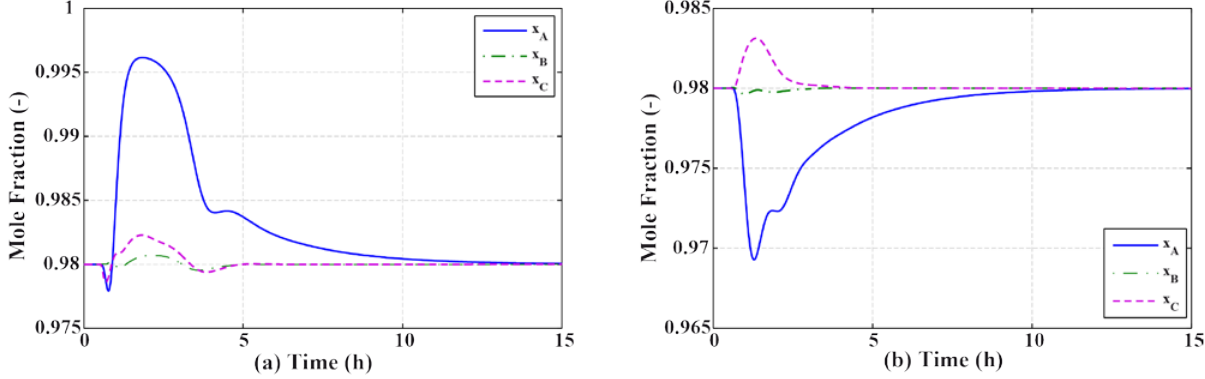
Figure 8. Dynamic response of LV-DSB control structure, under a disturbance of ( a ) +10% in the feed flow rate and ( b ) +10%